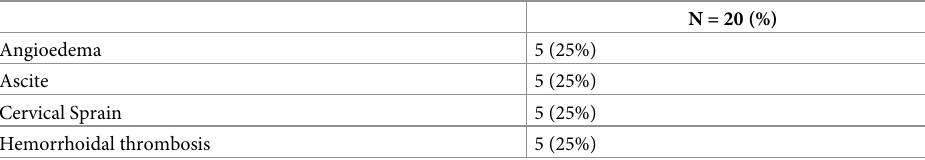
Table 2. Description of unknown diagnoses by the symptom